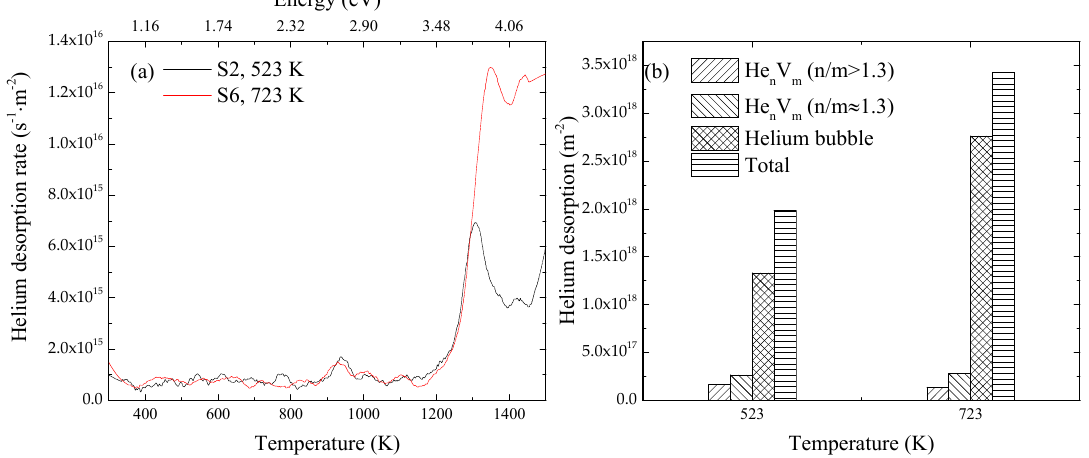
Figure 7. ( a ) Desorption spectra in specimens irradiated with 100 keV-He + at 523 K and 723 K to 1 × 10 20 m − 2 ; ( b ) amounts of helium released from various defect clusters and total helium amount released in specimens irradiated with 100 keV-He + at 523 K and 723 K to 1 × 10 20 m − 2